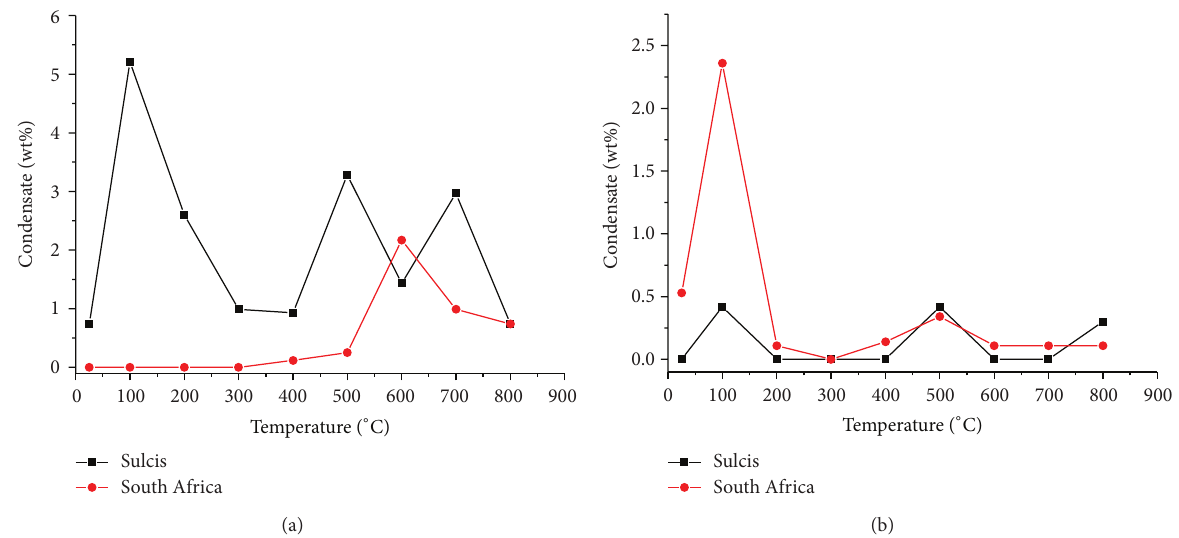
Figure 2: (a) Amount (wt%) of liquid materials collected in the cooling trap (a) against heating temperature. (b) Amount (wt%) of liquid materials collected in the cooling trap (b) against temperature.